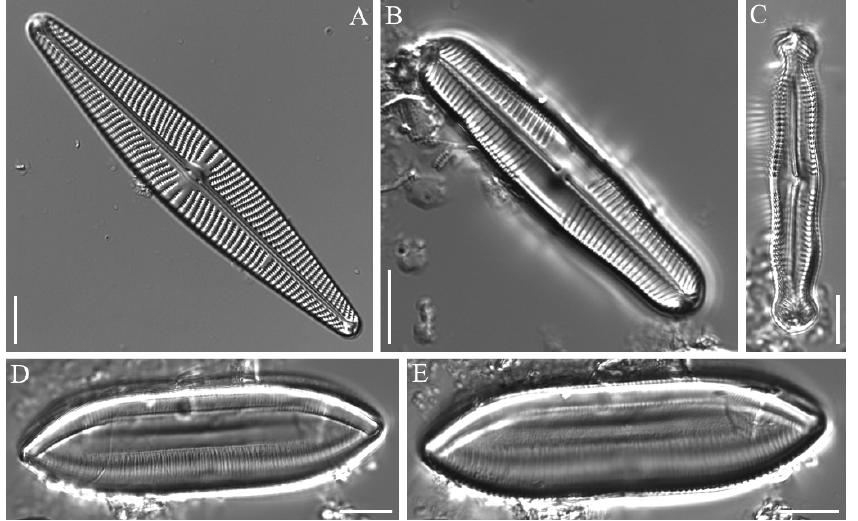
Figure 4. Light micrographs of diatoms. ( A ) Navicula freesei ( B ) Pinnularia bertrandii ( C ) Pinnularia nodosa var. percapitata ( D , E ) Tryblionella littoralis var. tergestina . Scale bars:10